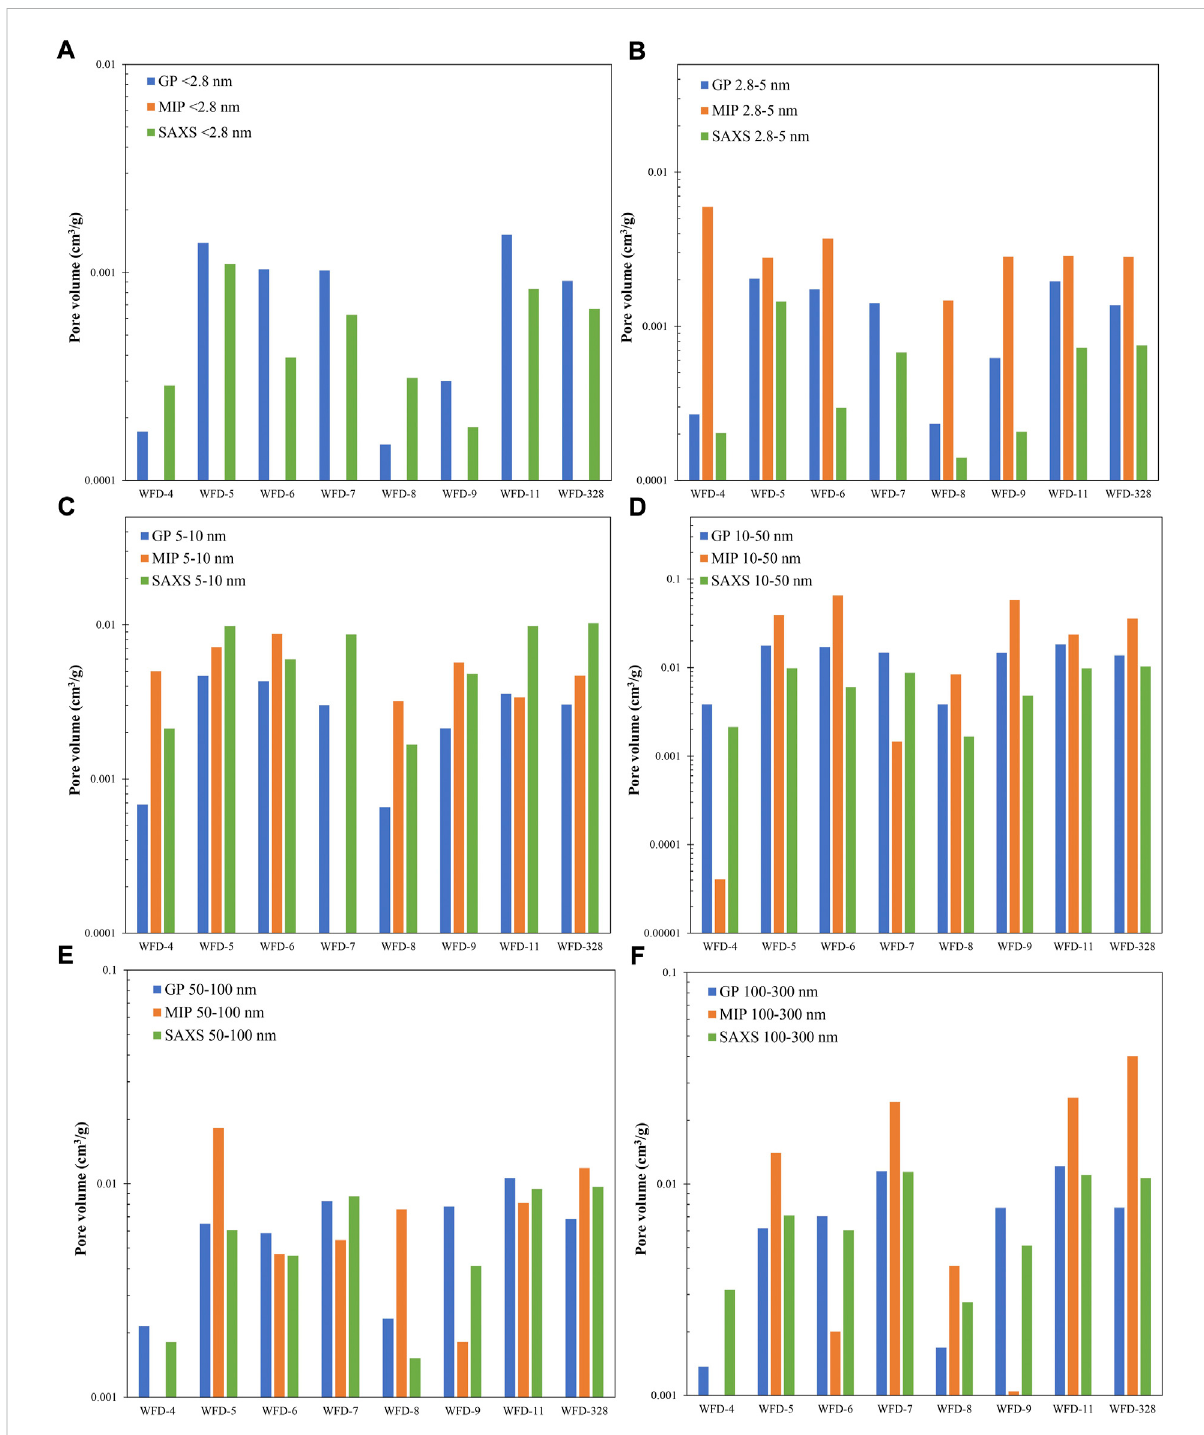
FIGURE 9 Pore volume comparison of GP, MIP, and (U)SAXS methods in six ranges; (A) < 2.8 nm; (B) 2.8 – 5 nm; (C) 5 – 10 nm; (D) 10 – 50 nm; (E) 50 – 100 nm; (F) 100 – 300